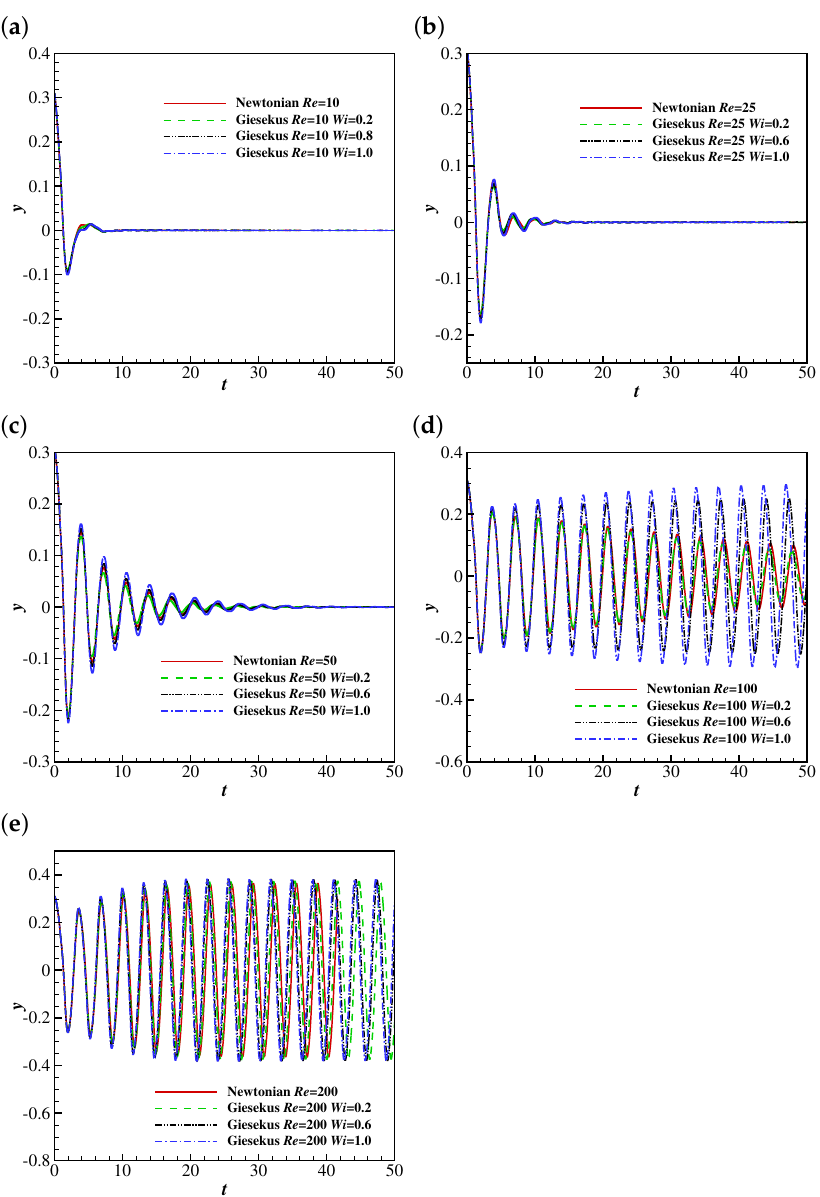
Figure 7. The time histories of the free-end position of the filament in Newtonian and Giesekus uniform flows at Re = ( a ) 10, ( b ) 25, ( c ) 50, ( d ) 100 and ( e )